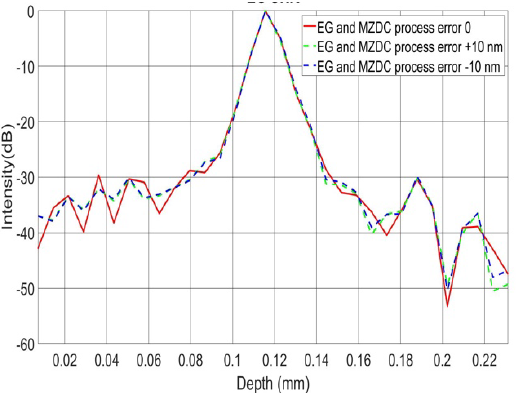
Figure 13. The point spread function only from the bidirectional MZDC with ED compensation.